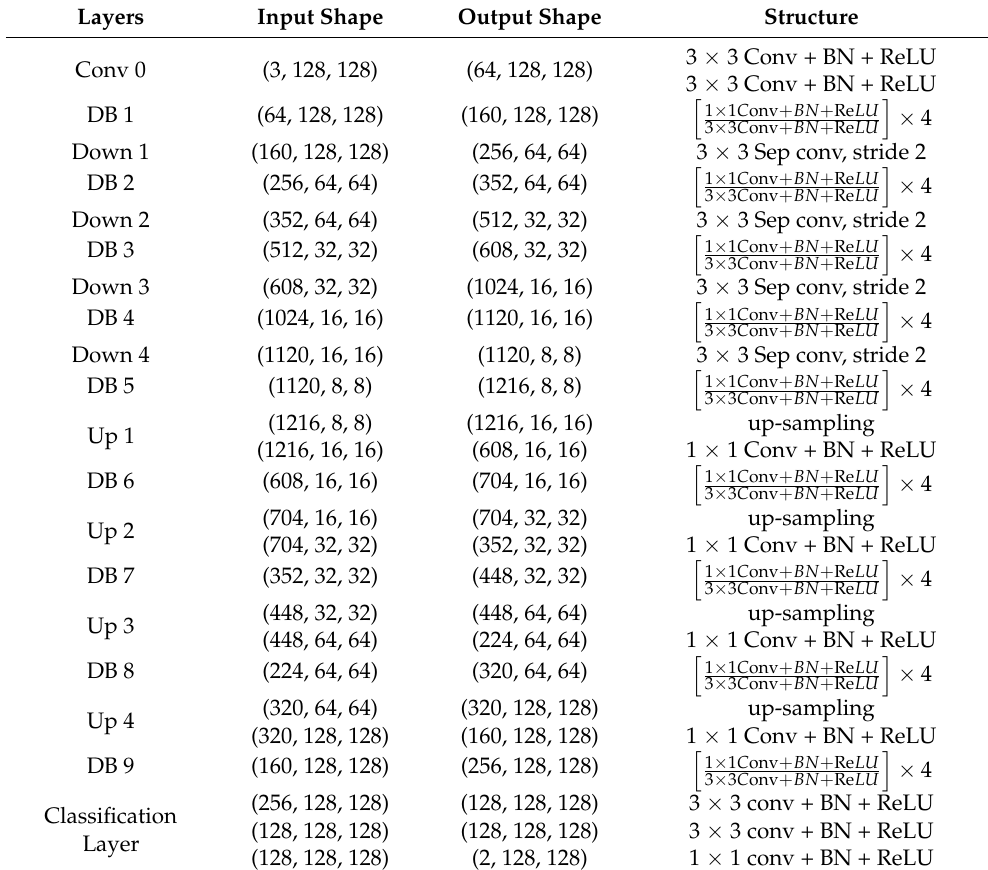
Table 1. Parameter settings for each layer in the DUPnet